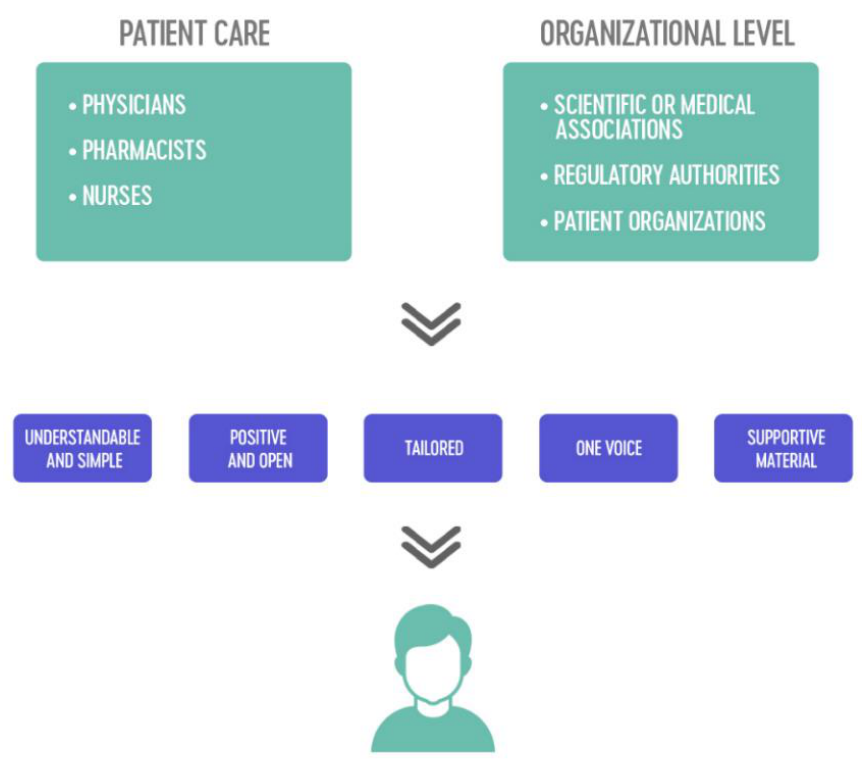
Figure 1. The multistakeholder approach using five main strategies for informing patients about biosimilars.